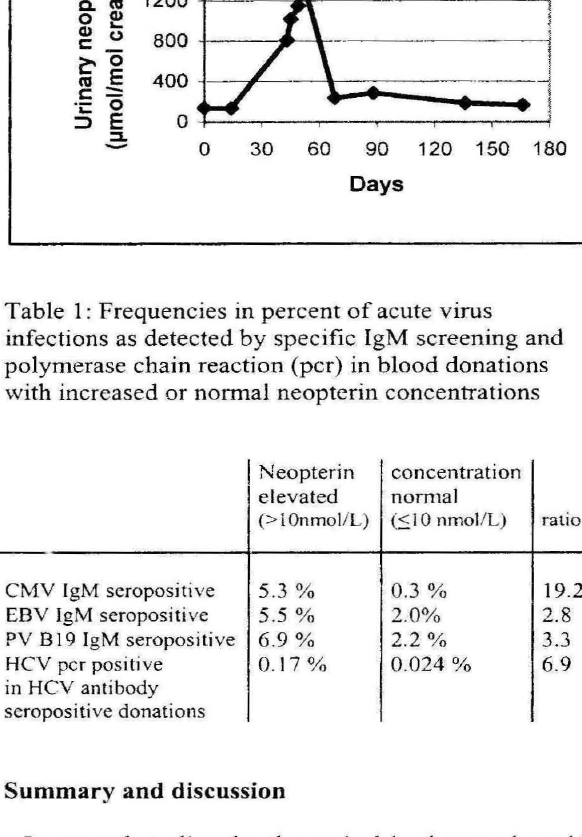
Fig.3: Urinary neopterin concentration in a young female (18 YEars of age) during acute Epstein-Barr virus infec:lOn (upper limit of normal = 97.S th percentik : 208 Jlmol neopterinimol creatinine) : :::